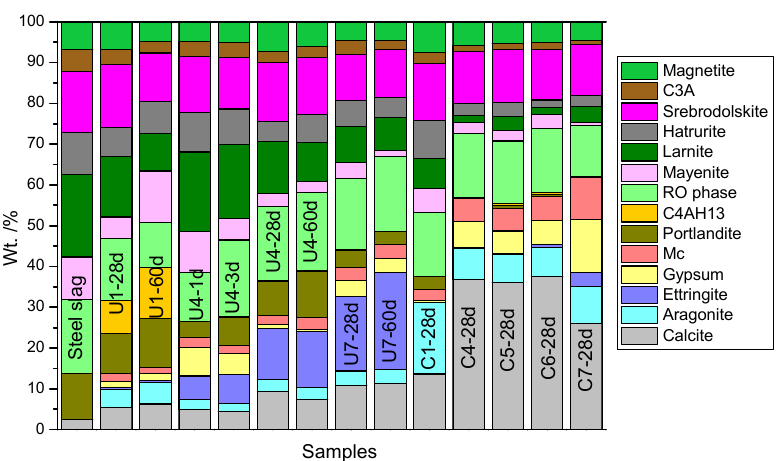
Figure 7. QXRD mineral analysis result for samples (Mc: Monocarboaluminate).